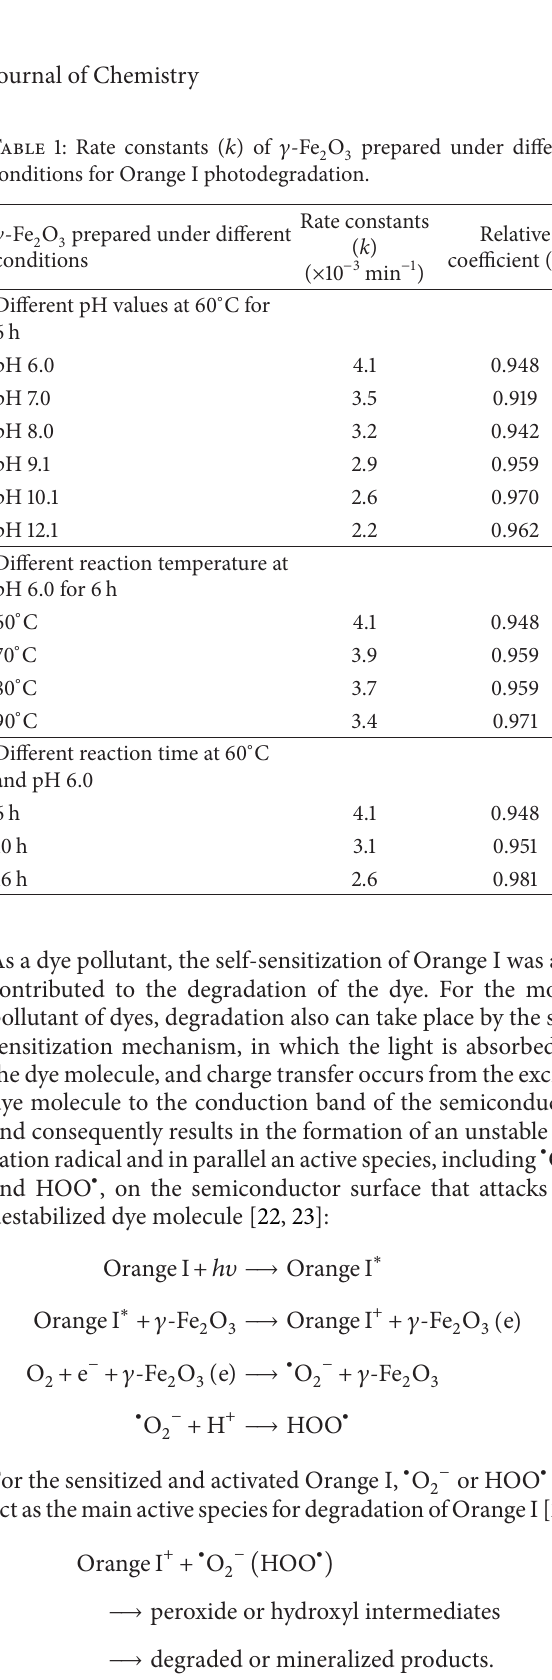
O prepared under different 2 3